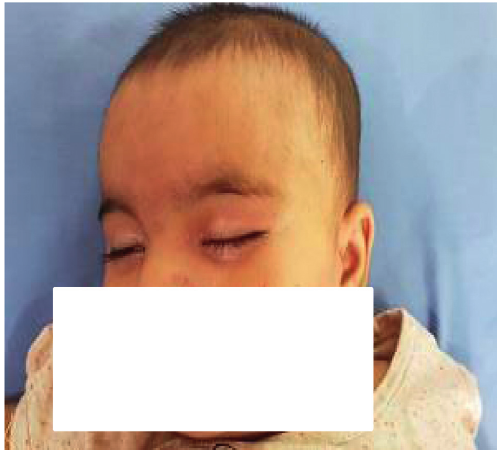
Figure 4: On discharge, the infant clinically